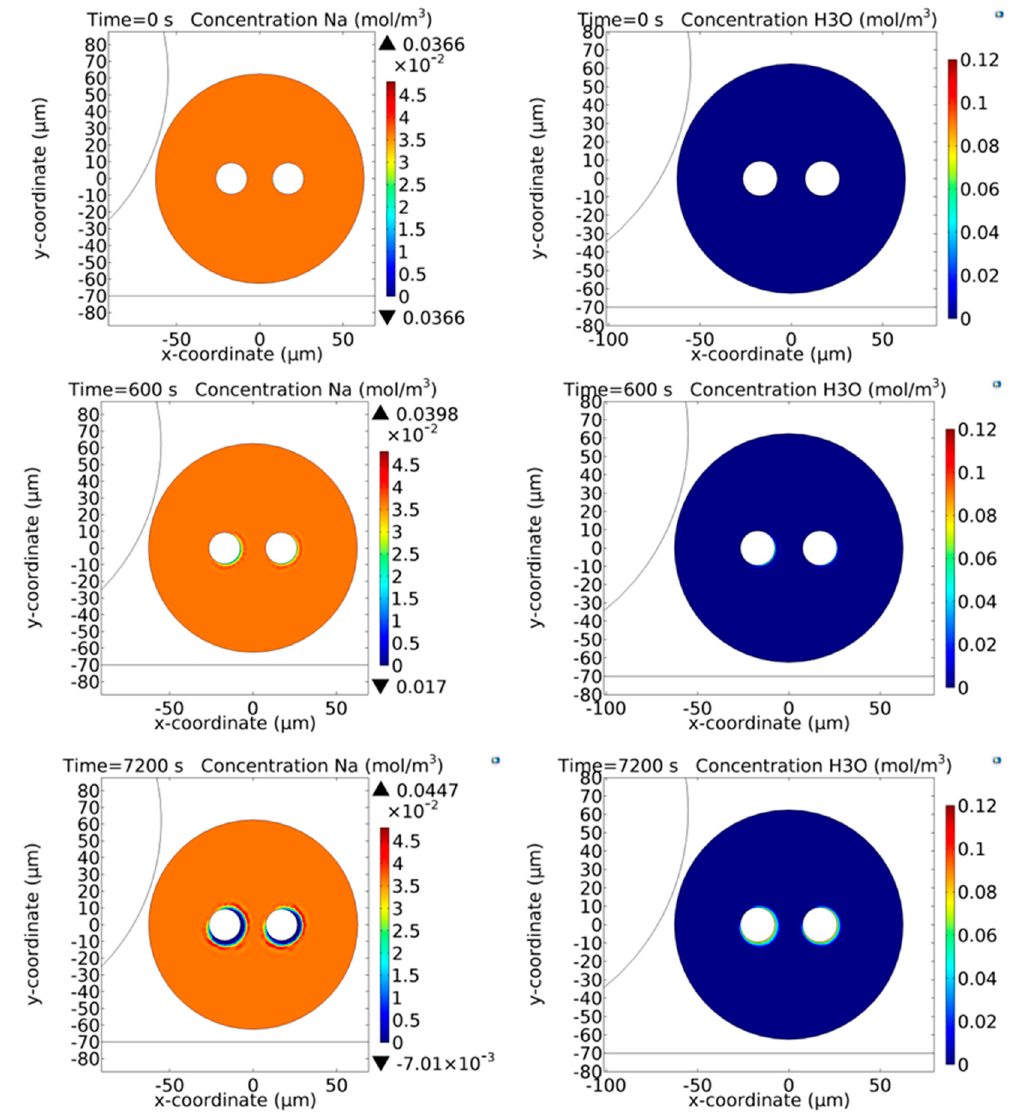
Figure 5. Time dynamics of the Na + ions calculated by means of the near model for induction poling. The Na + ions are considered mobile only in the fiber to be poled, while they are assumed to be motionless inside the inductor. Both the outer surfaces of the two fibers are not assumed to be grounded. The ground of the system is placed at a distance of 1 mm below the microscope slide surface. The concentration of the Na + ions is 1 ppm before the start of the poling process. Both the fibers are considered at a temperature of 300 ◦ C and the injection of the H 3 O + is assumed to be inexhaustible. The H 3 O + ions can consequently neutralize the NBO − centres previously depleted of Na + ions migrated as a result of the application of the external electric field. The two electrodes inserted in the cladding channels of the inductor are both connected to the same electric potential of + 5 kV [44].